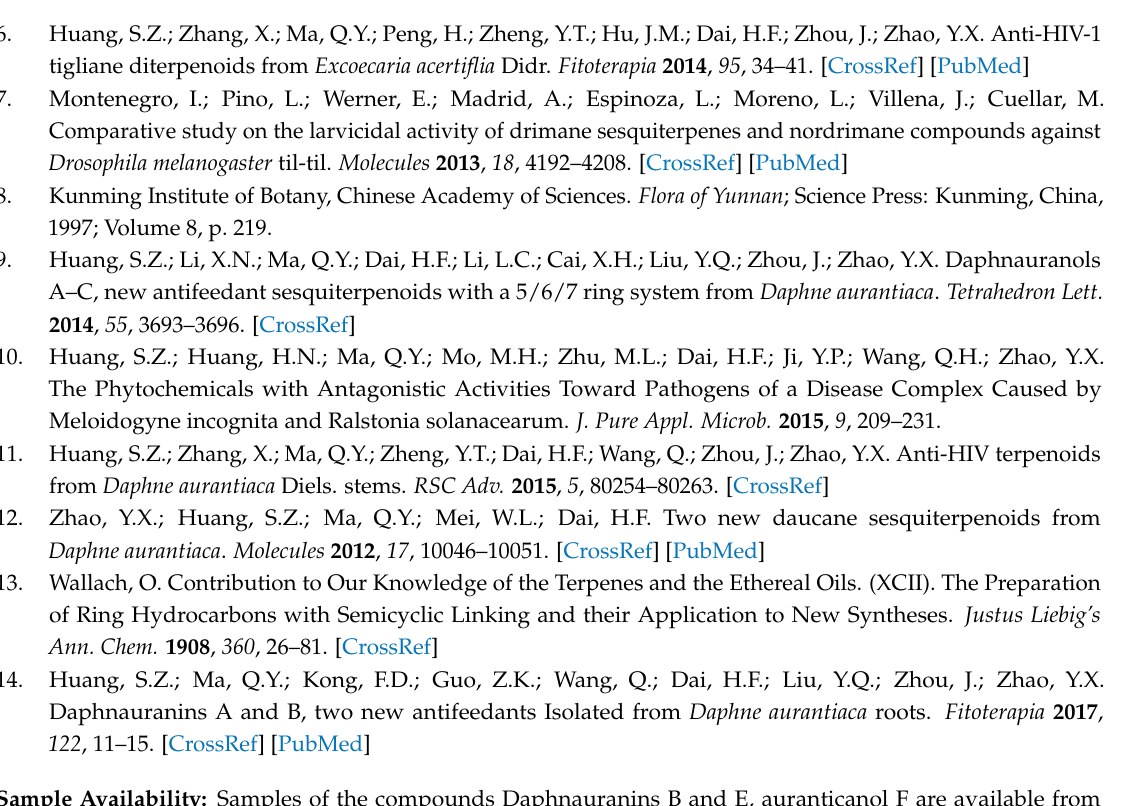
Sample Availability: Samples of the compounds Daphnauranins B and E, auranticanol F are available from the